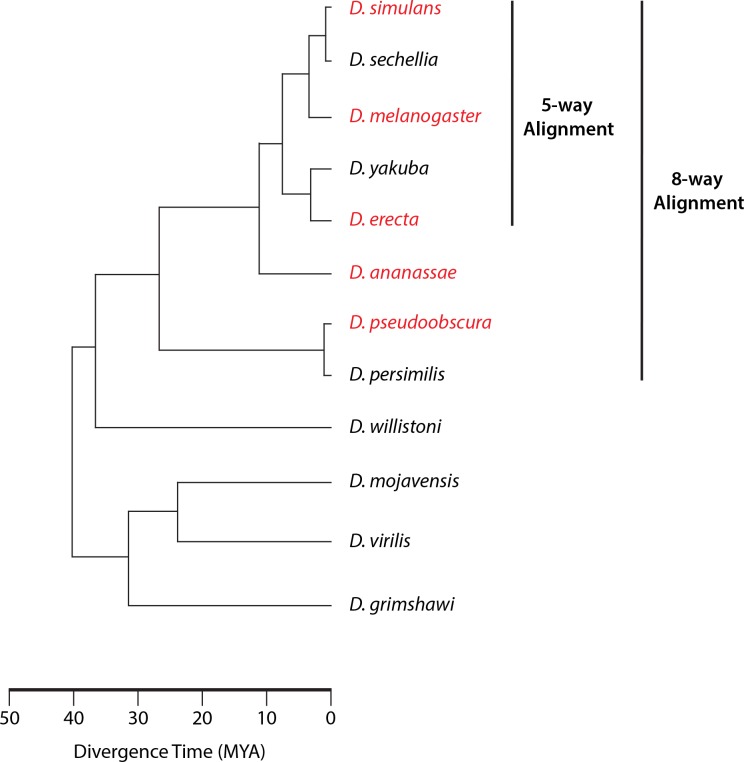
Phylogeny of sequenced species.The species for which we gathered data appear in red. When assessing sequence conservation for features conserved across all five species studied, we included the genome sequences of the five species studied and the three additional sequenced species from the same monophyletic group (8-way alignment). When assessing conservation throughout the melanogaster subgroup, we used the genomes of our three species and the other two from the subgroup (5-way alignment).